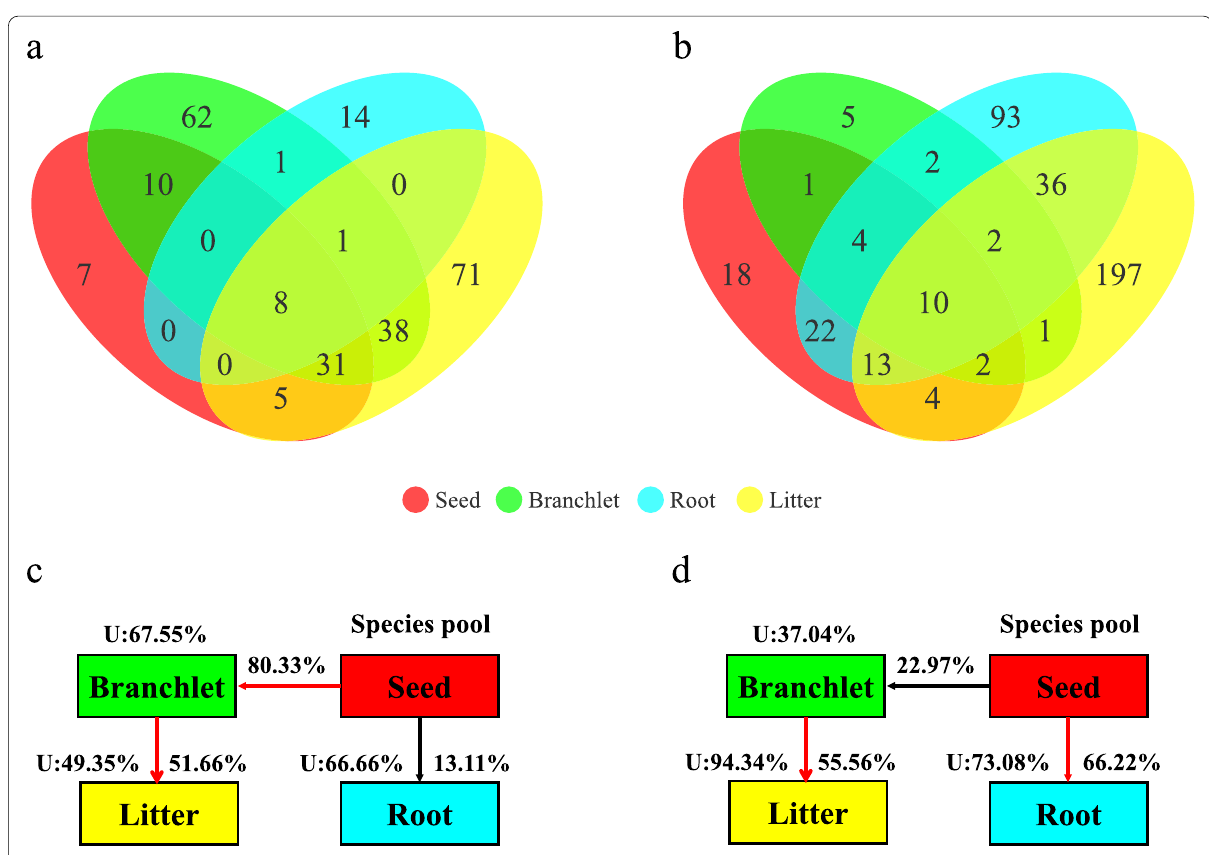
Fig. 4 Endophytes in seeds acting as the species pool transmit to different ecological niches. OTU Venn analysis represents the characteristics: shared and specific microorganisms in different ecological niches, namely, a showing endophytic fungi and b showing endophytic bacteria in seeds, branchlets, roots, and litter of C. equisetifolia at the genus level. c , d Vertical dispersal of endophytic fungi (left) and bacteria (right) in seeds, branchlets, roots, and litter of C. equisetifolia at genus stand. U represents an unknown